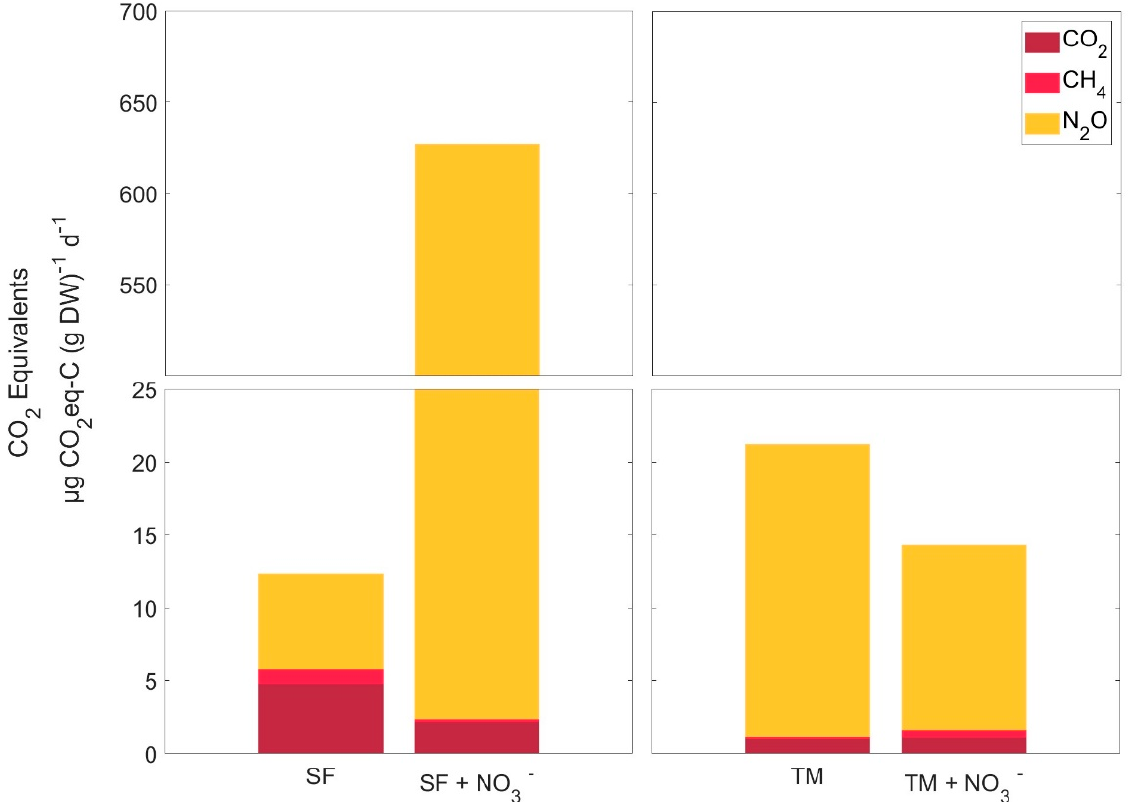
Figure 4. Contribution of CO 2 (dark red), CH 4 (bright red) and N 2 O (yellow) to total CO 2 equivalents measured in anaerobic incubated (4 °C) slump floor (SF, left) and thaw mound soils (TM, right) without and with nitrate addition (152 mM). For a better visualization the y–axis is broken.